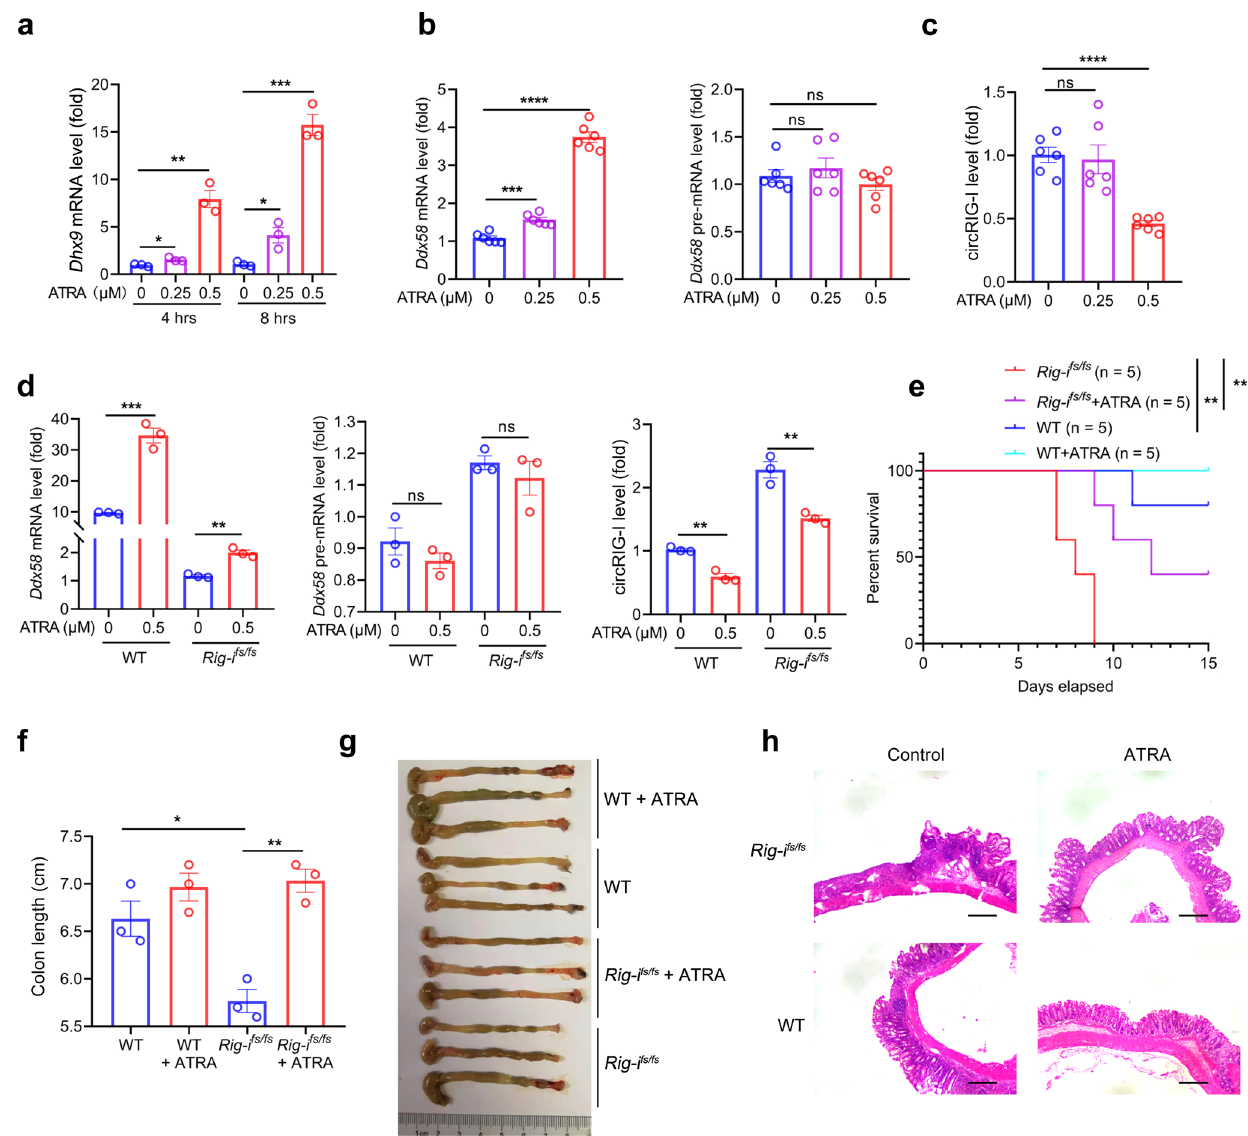
Fig. 8 | All-trans retinoic acid alleviates colonic in fl ammatory lesion of Rig-i fs/fs mice. a RT-qPCR analysis of Dhx9 mRNA in MEFs with ATRA treatment ( n =6 cell cultures, mean ± s.e.m., ns, * P =0.0177 (4h), * P =0.0204 (8h), ** P =0.0015, *** P =0.0002, two-tailed unpaired Student ’ s t-test). b-c RT-qPCR analysis of Ddx58 mRNA and pre-mRNA aswell as circRIG-I expression in MEFs with ATRA treatment ( n =6 cell cultures, mean ± s.e.m., ns, not signi fi cant ( P >0.05), *** P =0.0001, **** P <0.0001, two-tailed unpaired Student ’ s t-test). d RT-qPCR analysis of mRNA and pre-mRNA of Ddx58 , circRIG-I expression in wild-type (WT) and Rig-i fs/fs MEFs withATRAtreatment( n =3cellcultures,mean±s.e.m.,ns,notsigni fi cant( P >0.05), ** P =0.0012 ( Ddx58 ), ** P =0.0016 (WT, circRIG-I), ** P =0.0051 ( Rig-i fs/fs , circRIG-I), *** P =0.0005, two-tailed unpaired Student ’ s t-test). e Survival analysis of wild-type